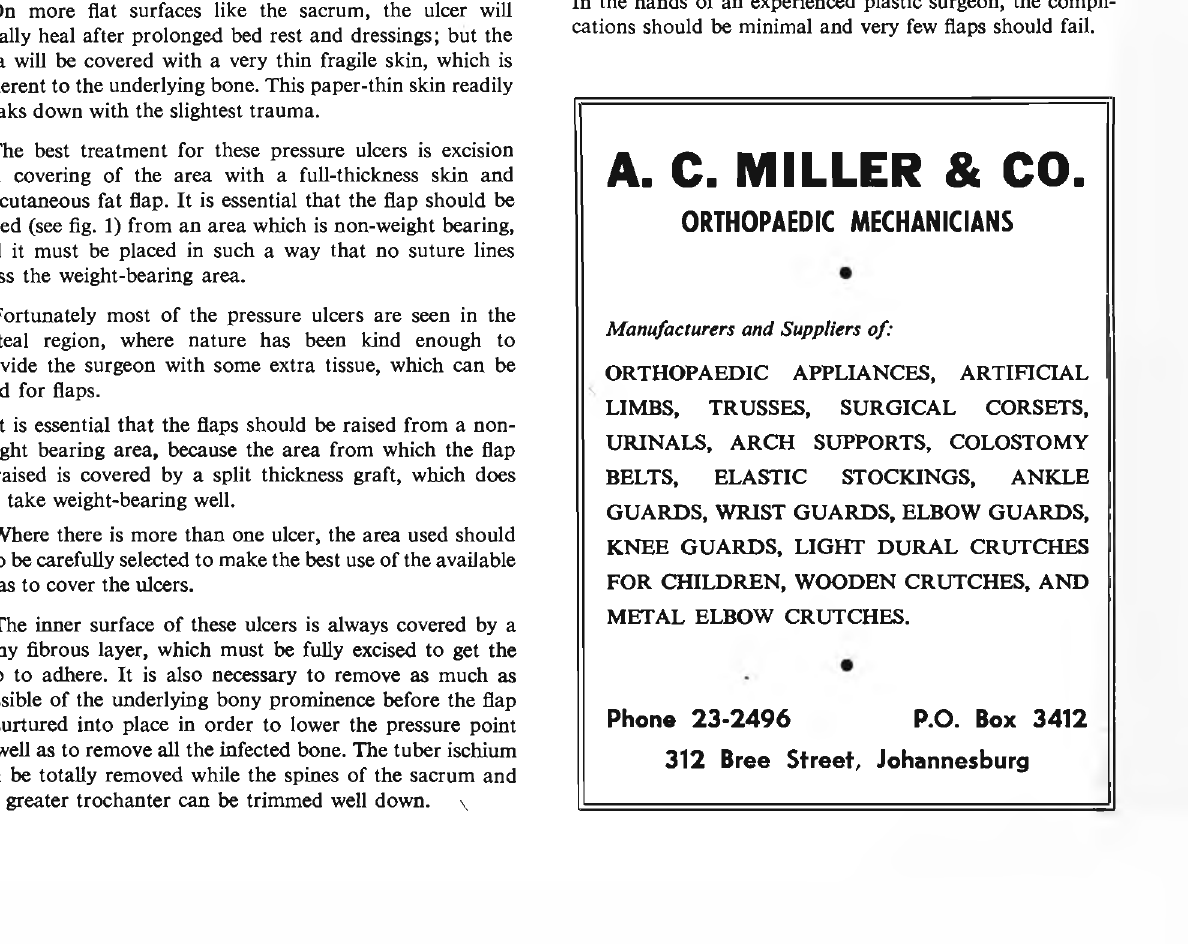
Ulcer over greater trochanter and tuber ischium after repair